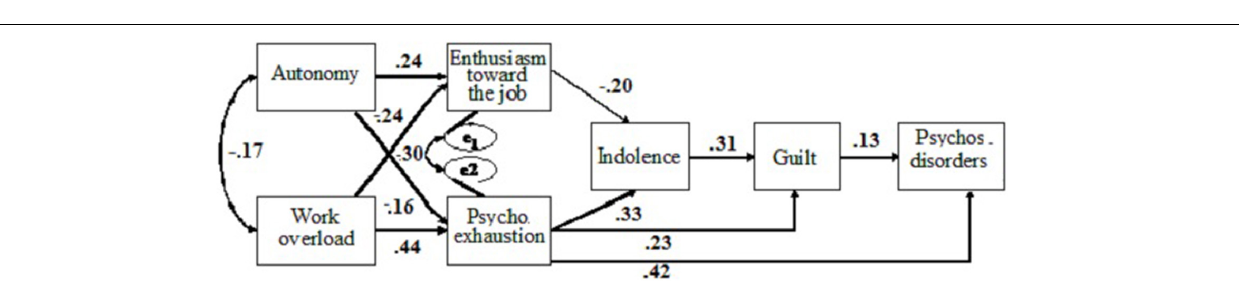
between the errors were balanced in the two samples. In this case, the unrestricted model obtained a value χ 2 ( 18 ) = 95.677 and the completely restricted model χ 2 ( 25 ) = 109.319, with